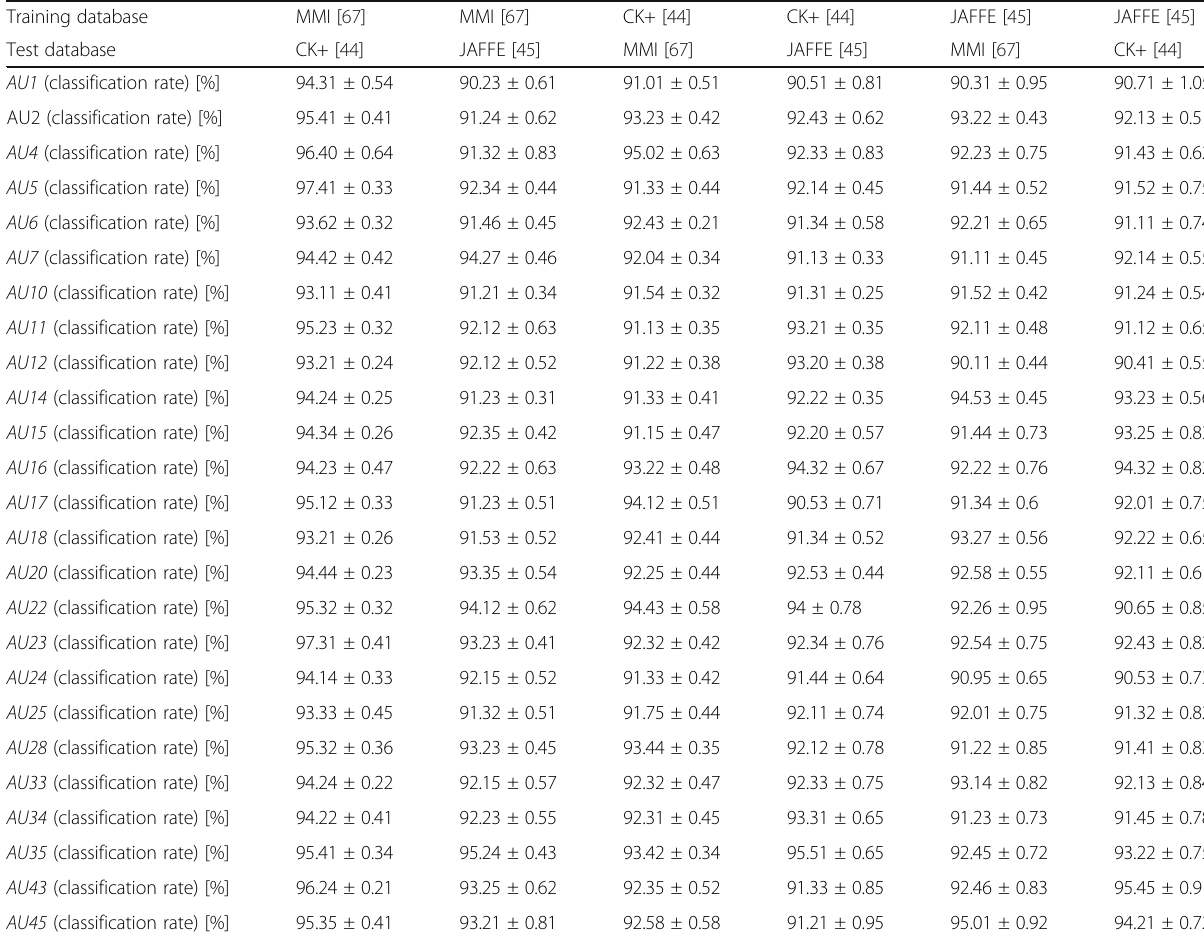
Table 1 AUs ’ classification rates for different cross-database tests Training